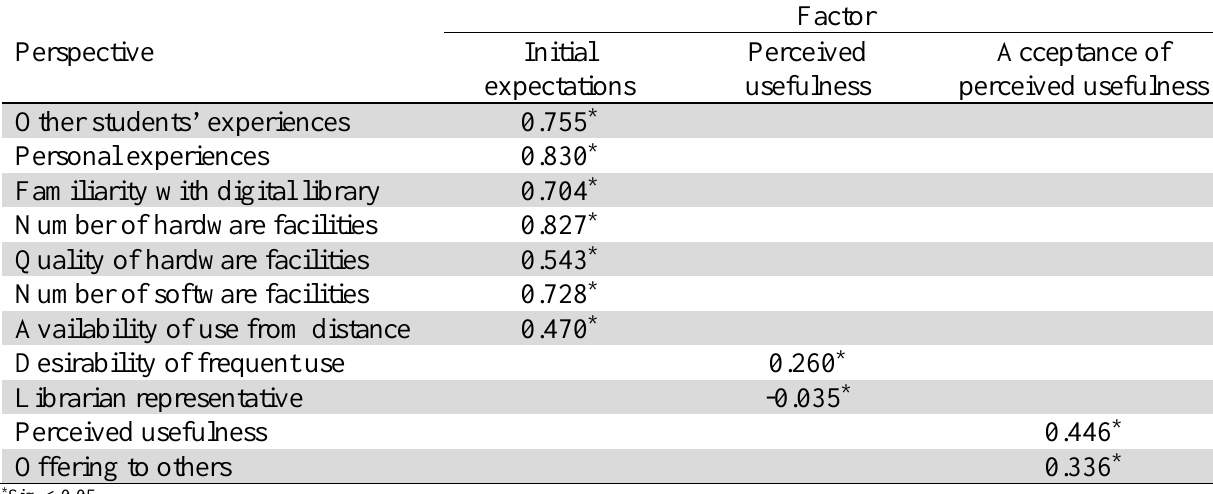
The summary of rotated correlation